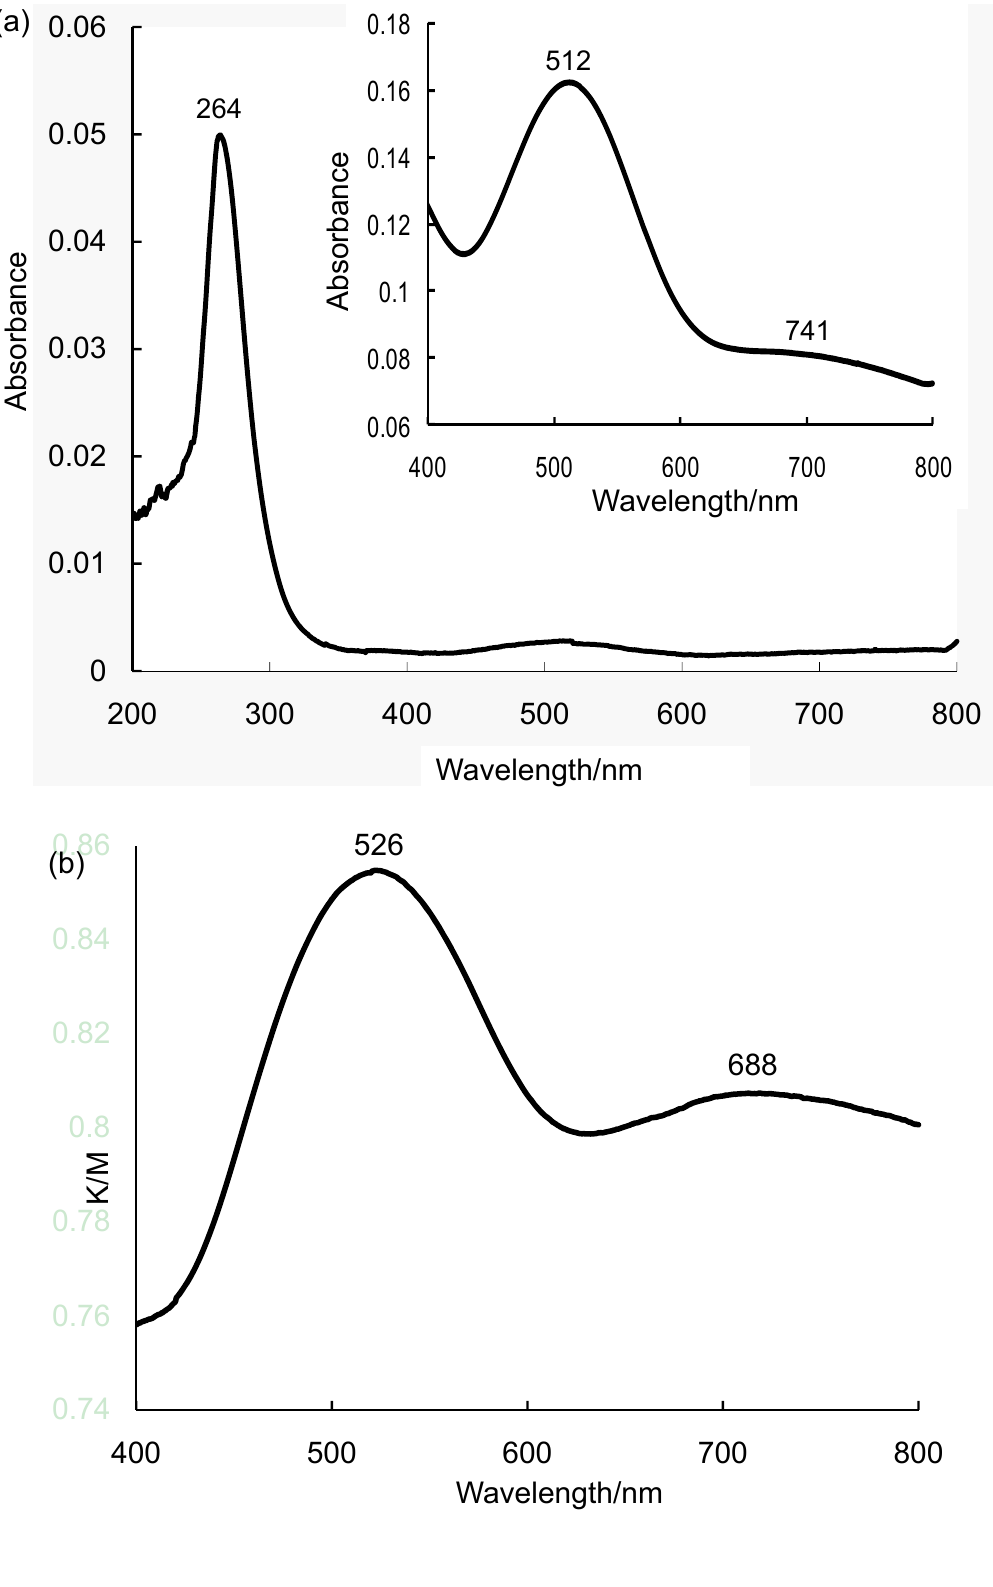
Figure 4. (a) UV-vis spectrum in DMSO of Me Inset: 400–800 nm (1.0 × 10 -4 M). (b) Diffuse reflectance UV-vis spectrum of Me 400–800